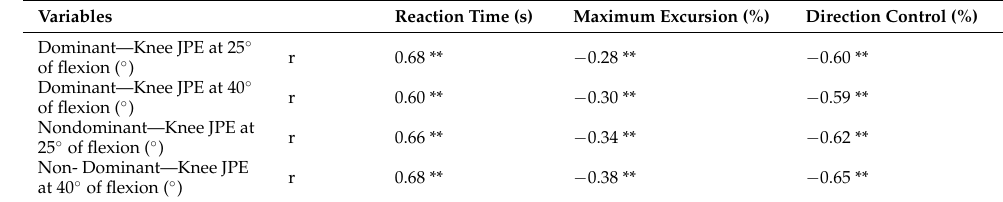
Table 3. Relationship between cervical joint position error and balance and limits of stability tests ( n = 200).